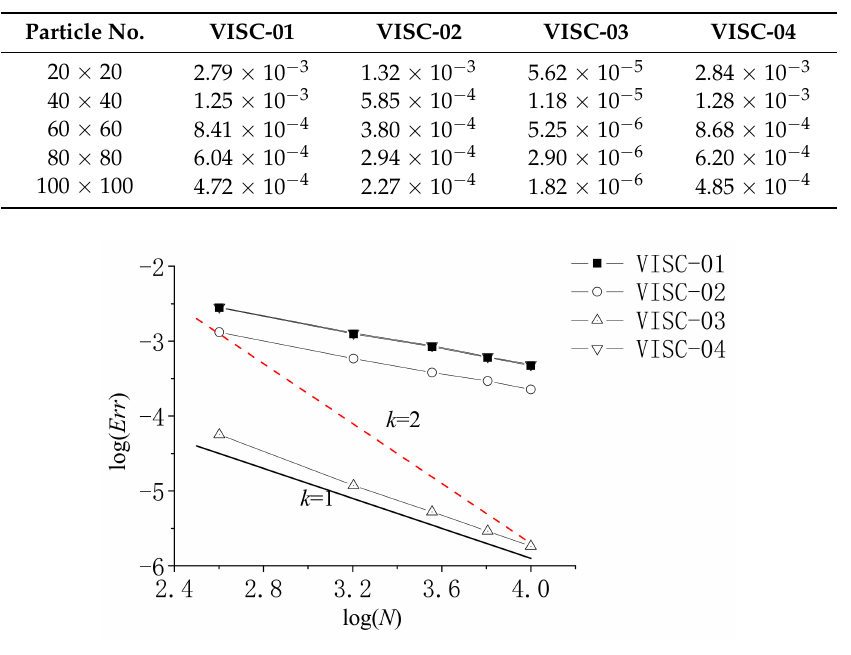
Figure 5. Convergence and error analysis of different viscosity force models under the non-uniform particle distribution.